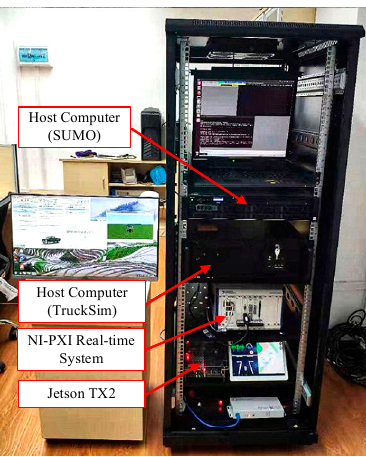
Figure 8. Overall architecture of the HIL platform.